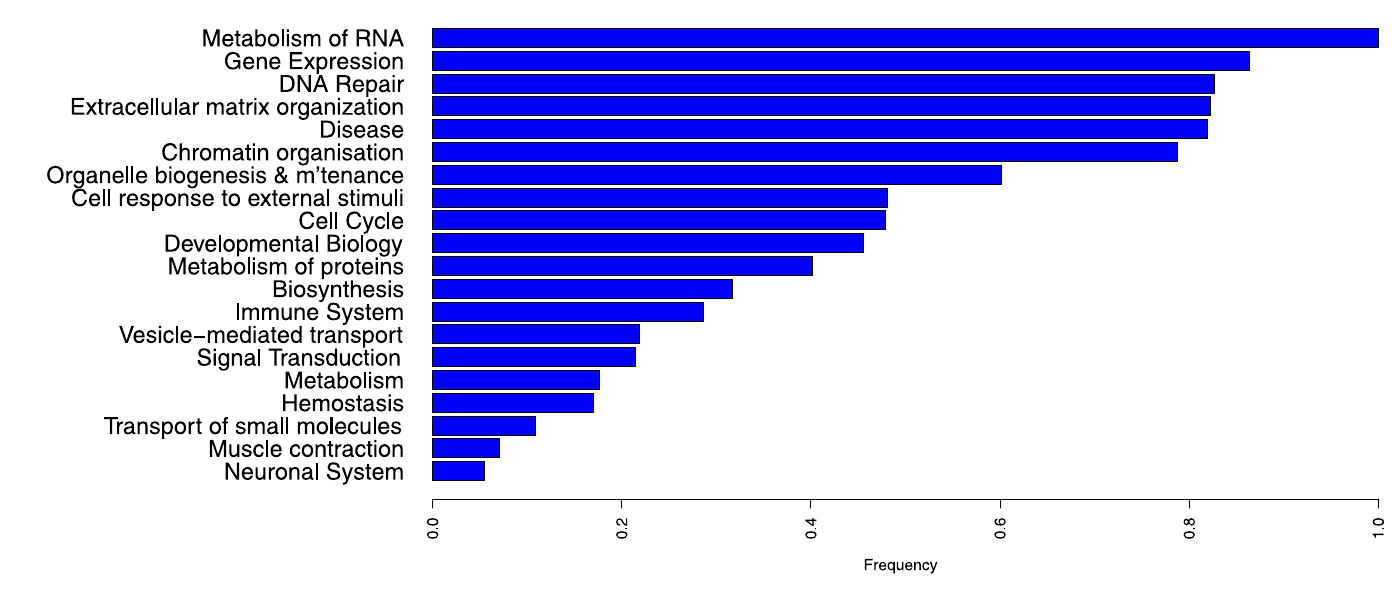
Fig 3. Frequency of occurrence of the major types of pathway amongst the enriched pathways of the 250 regulators.